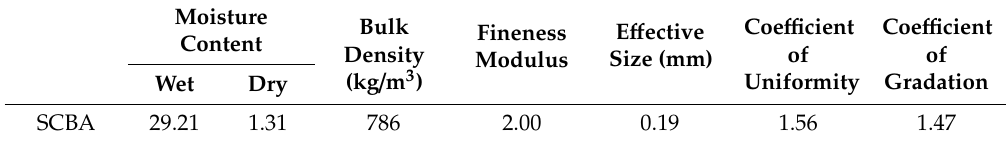
Table 5. Physical properties of